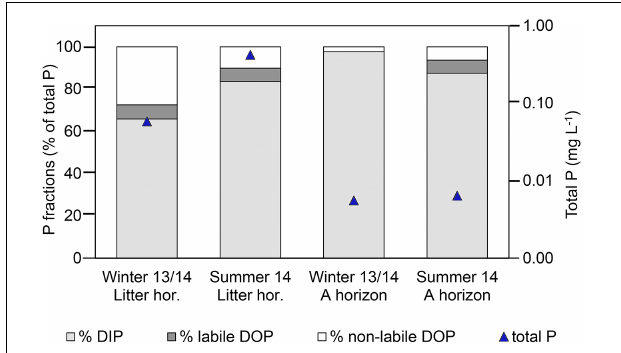
FIGURE 2 | Phosphorus (P) forms in leached soil solutions from the litter and the A horizon at the P-rich site Bad Brückenau (BBR) in Winter 2013/2014 and Summer 2014, as revealed by enzyme addition assays with phosphomonoesterase addition; DIP, dissolved inorganic P; DOP, dissolved organic P.